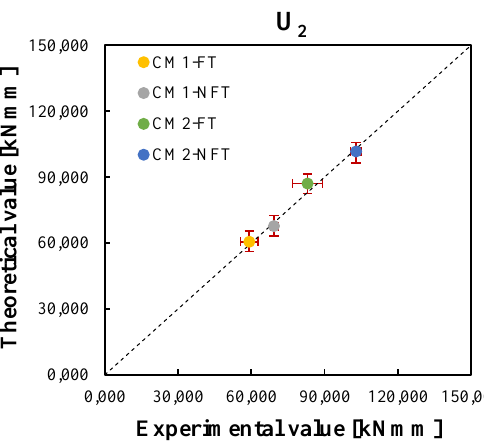
Figure 13. Correlation between the experimental and theoretical average values of the working ca- pacity indices after the freeze – thaw cycles, 𝑈 1,𝑎𝑣𝑔𝐹𝑇 , and before the freeze – thaw cycles of Ref. [42], 𝑈 1,𝑎𝑣𝑔𝑁𝐹𝑇 , for the CM1 and CM2 mixtures.